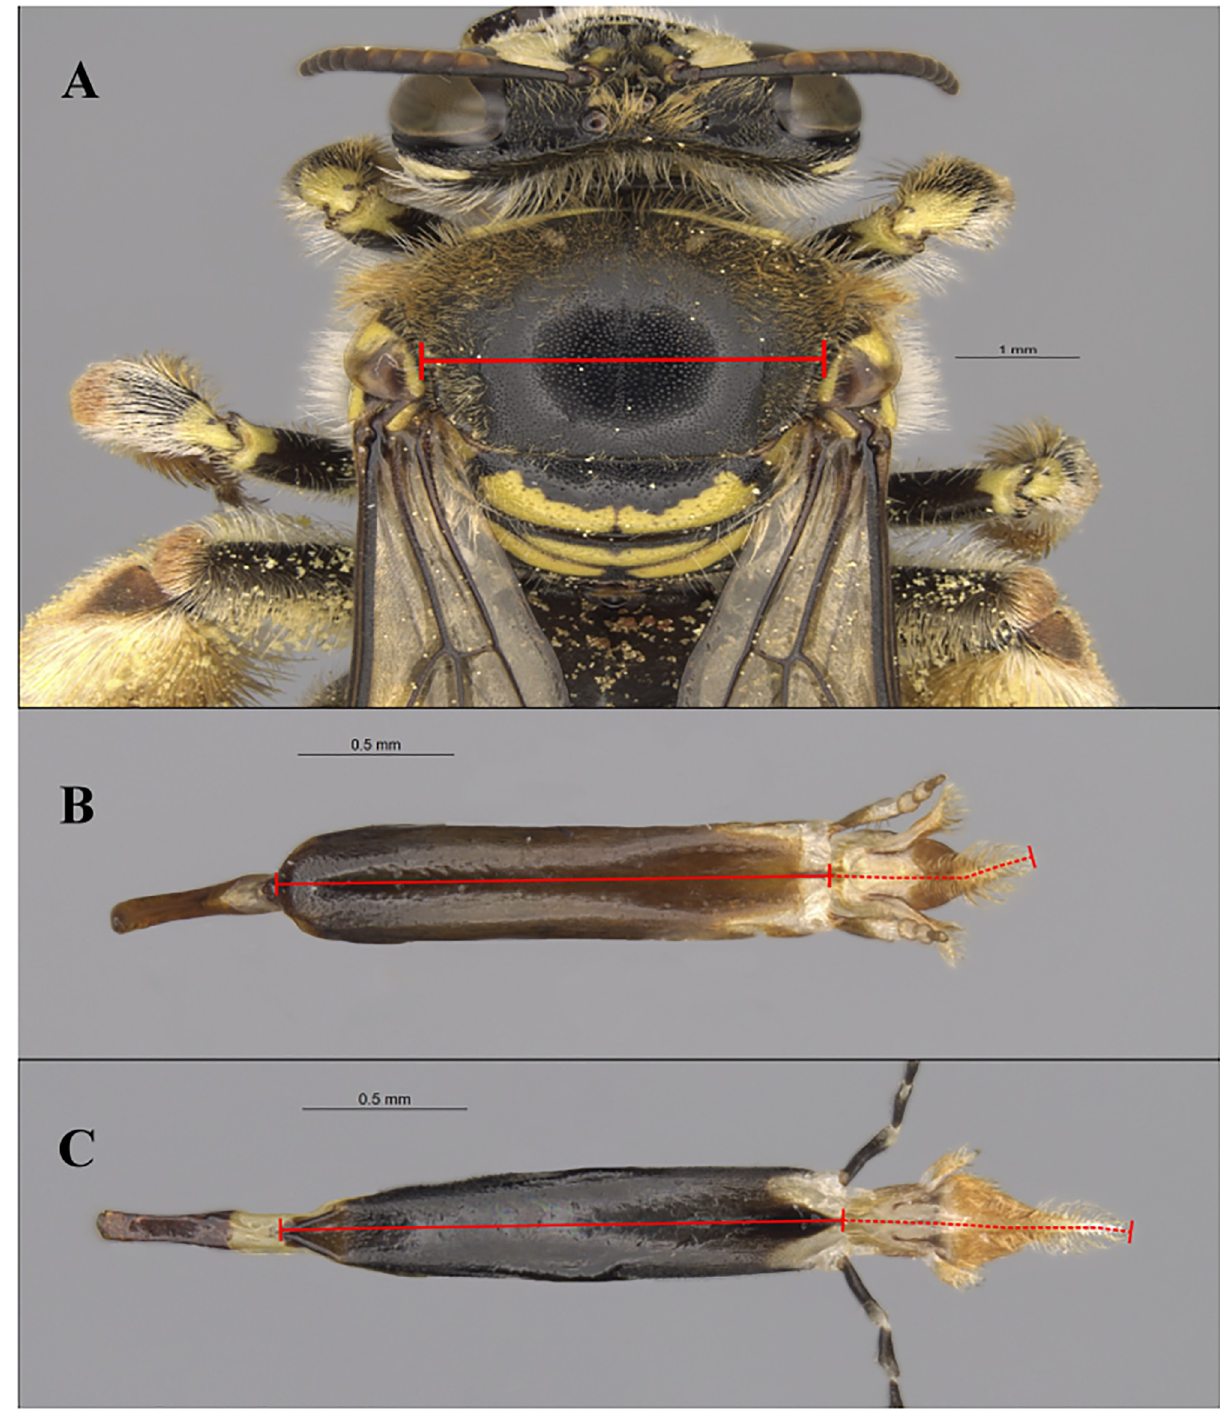
Fig 1. Photographs of the intertegular distance (IT) and dissected proboscis (glossa + prementum). (A) Photograph of IT for Meganomia binghami Cockerell (Melittidae) ♀ (B) Glossa (depicted by dashed red lines) and prementum (depicted by solid red lines) length for short-tongued Melittidae bees Meganomia binghami ♀ and (C) Redivivoides simulans Michener ♀ .